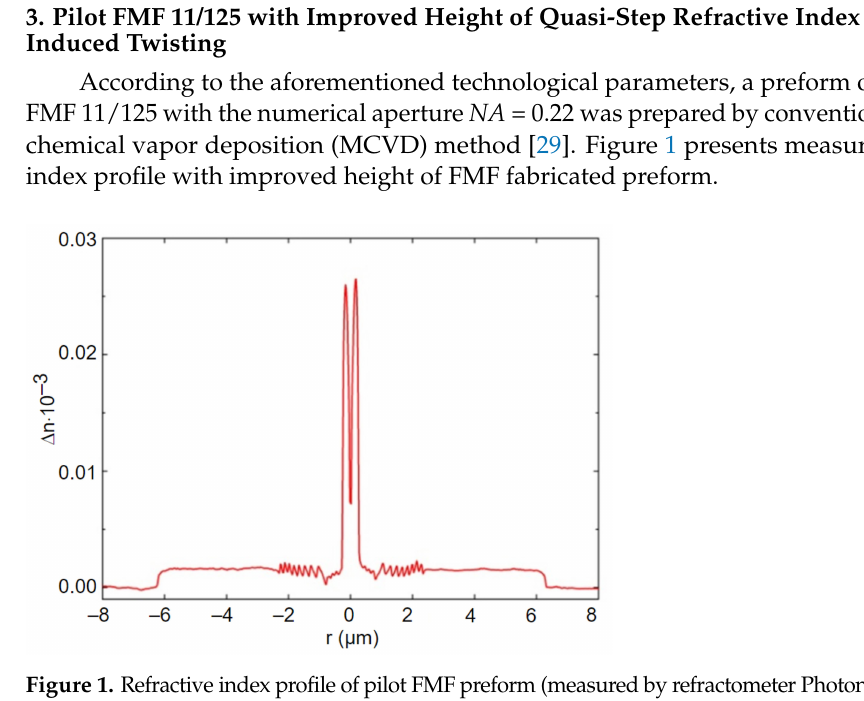
Figure 1. Refractive index profile of pilot FMF preform (measured by refractometer Photon Kinetics